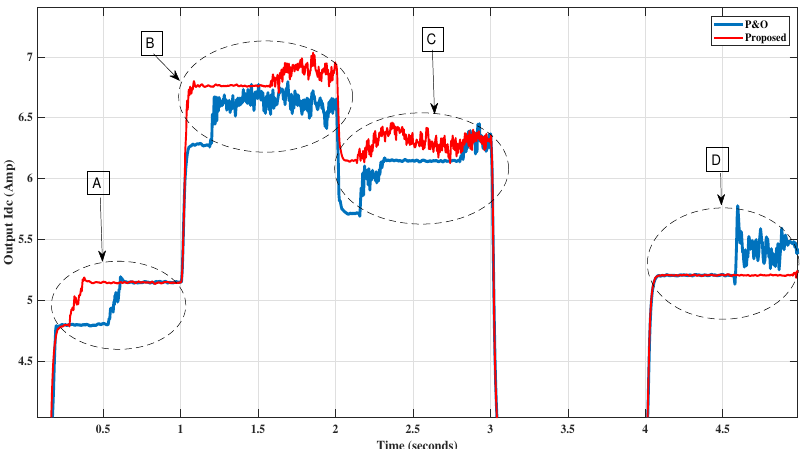
Figure 21. Time and output current—zoomed sections. At wind speeds of 10 m/s, 12 m/s, and 11 m/s denoted by sections A, B, and C, the current obtained for the proposed algorithm is considerably greater than that obtained for the CPO